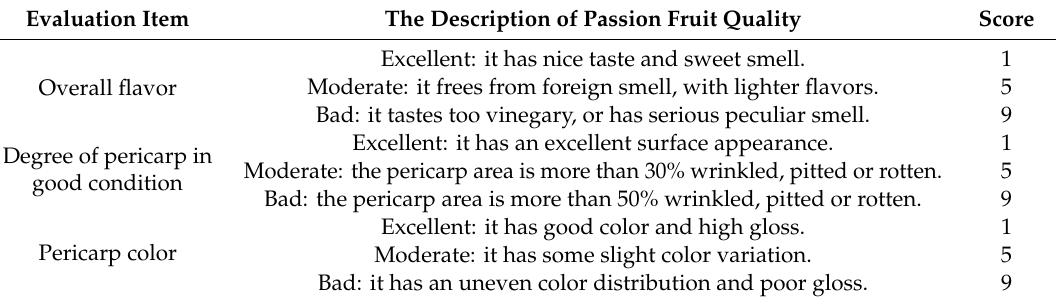
Table 2. The score criterion of sensory evaluation of passion